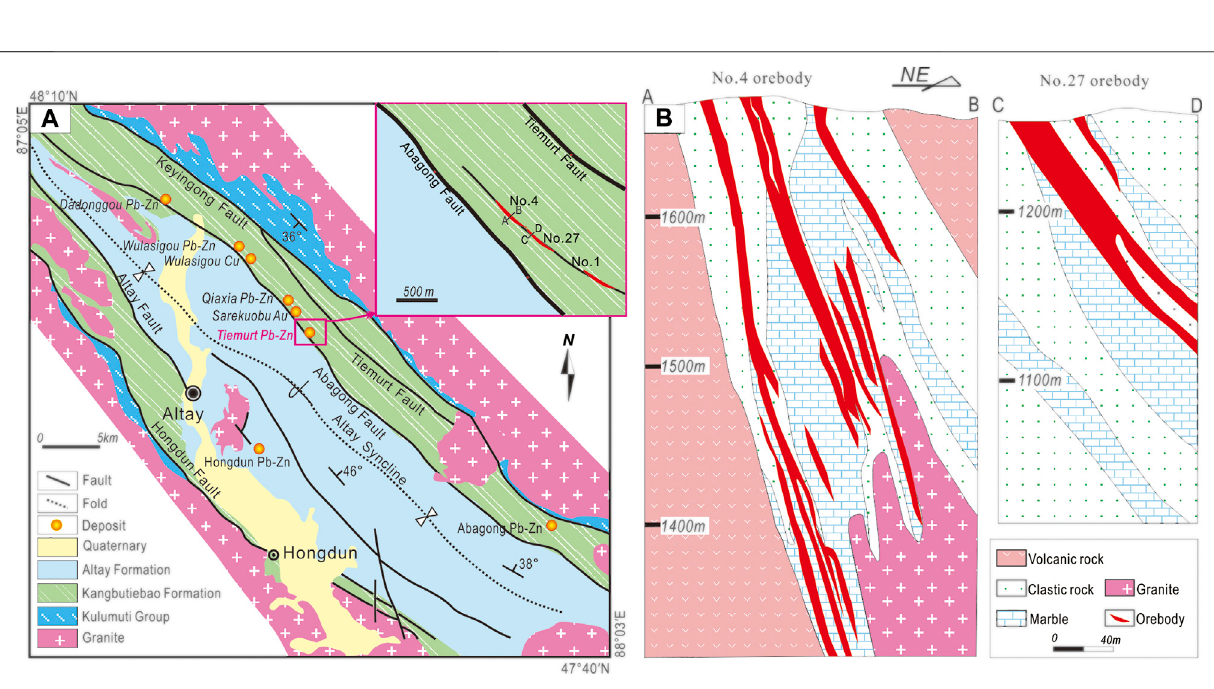
FIGURE 2 | (A) Geological map of the Kelan Basin and ore deposits, and the inserted geological map of the Tiemurt Pb – Zn – Cu deposit (modi fi ed after Geological Team706oftheXinjiangBureauofNonferrousMetals,2000). (B) GeologicalcrosssectionsoftheTiemurtorebodiesNo.4andNo.27(modi fi edafterXinjiangGeological Team 706,